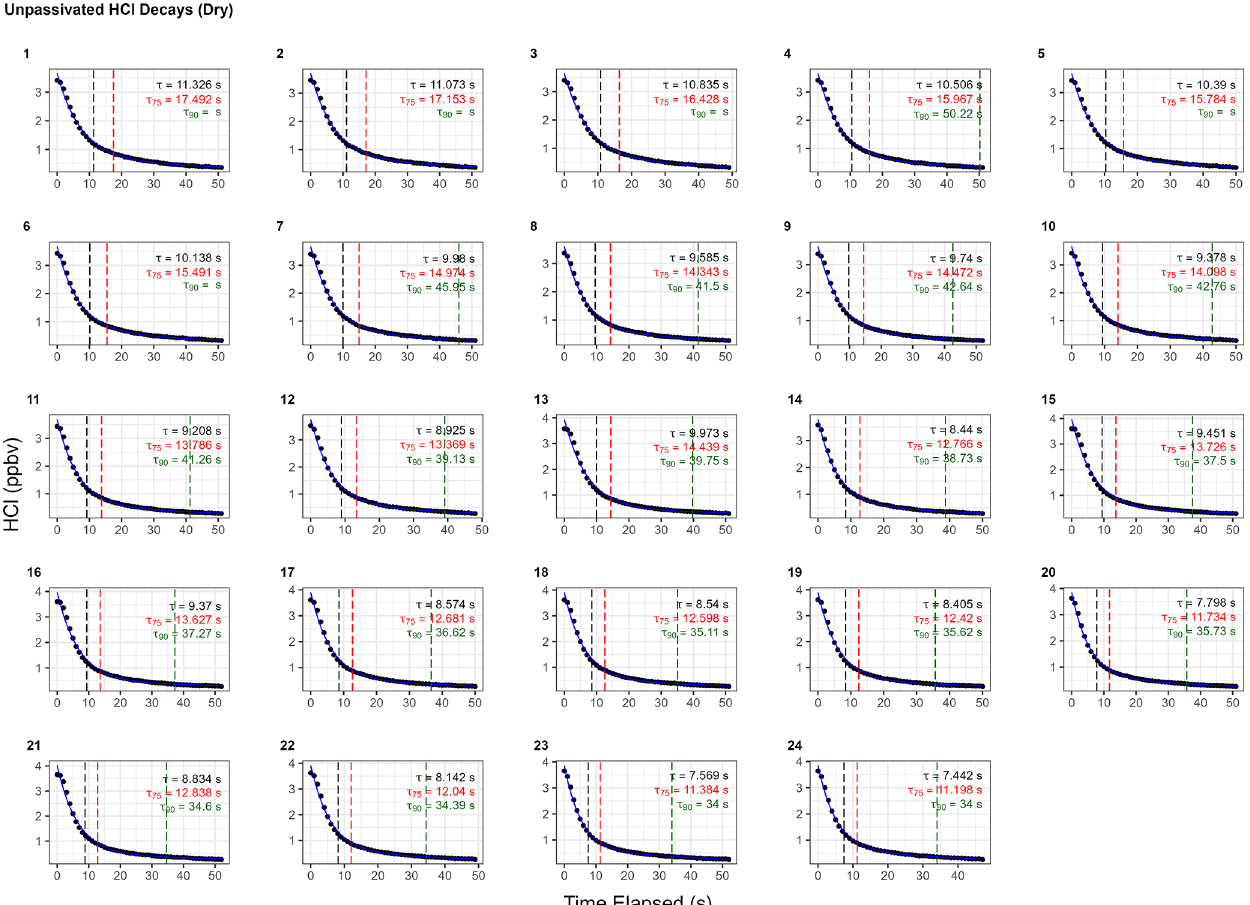
Figure A3. Instrument response times to changes in HCl mixing ratios without active chemical passivation. Black dots represent observed data and are overlaid by the calculated bi-exponential model (according to the terms listed in Table A2). Vertical hashed lines are placed on time elapsed corresponding to τ e (black), τ 75 (red), and τ 90